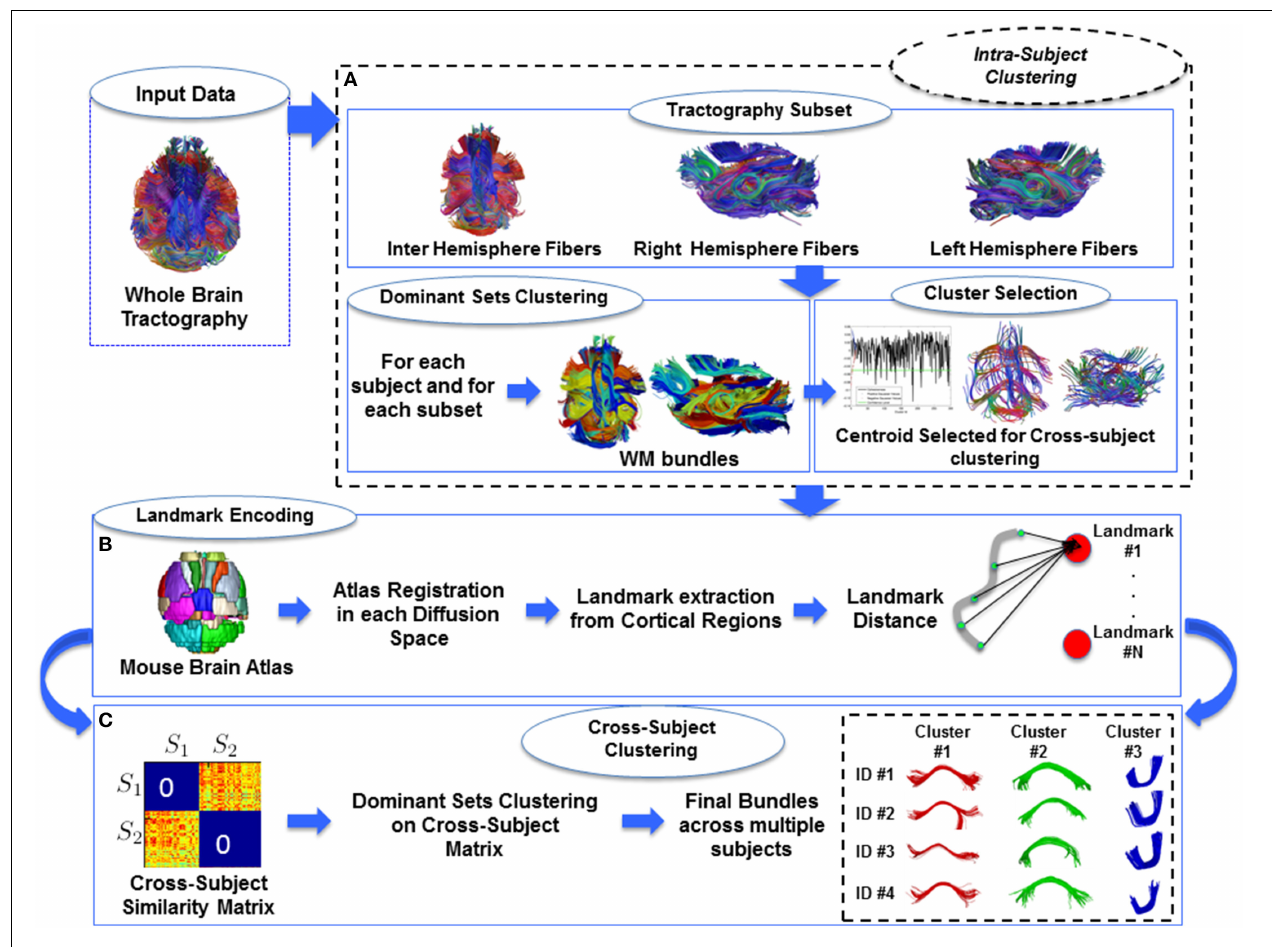
intra-cluster step was encoded on landmarks. (C) Cross-Subject clustering through affinity block matrix and Dominant Set to find out same WM bundles across